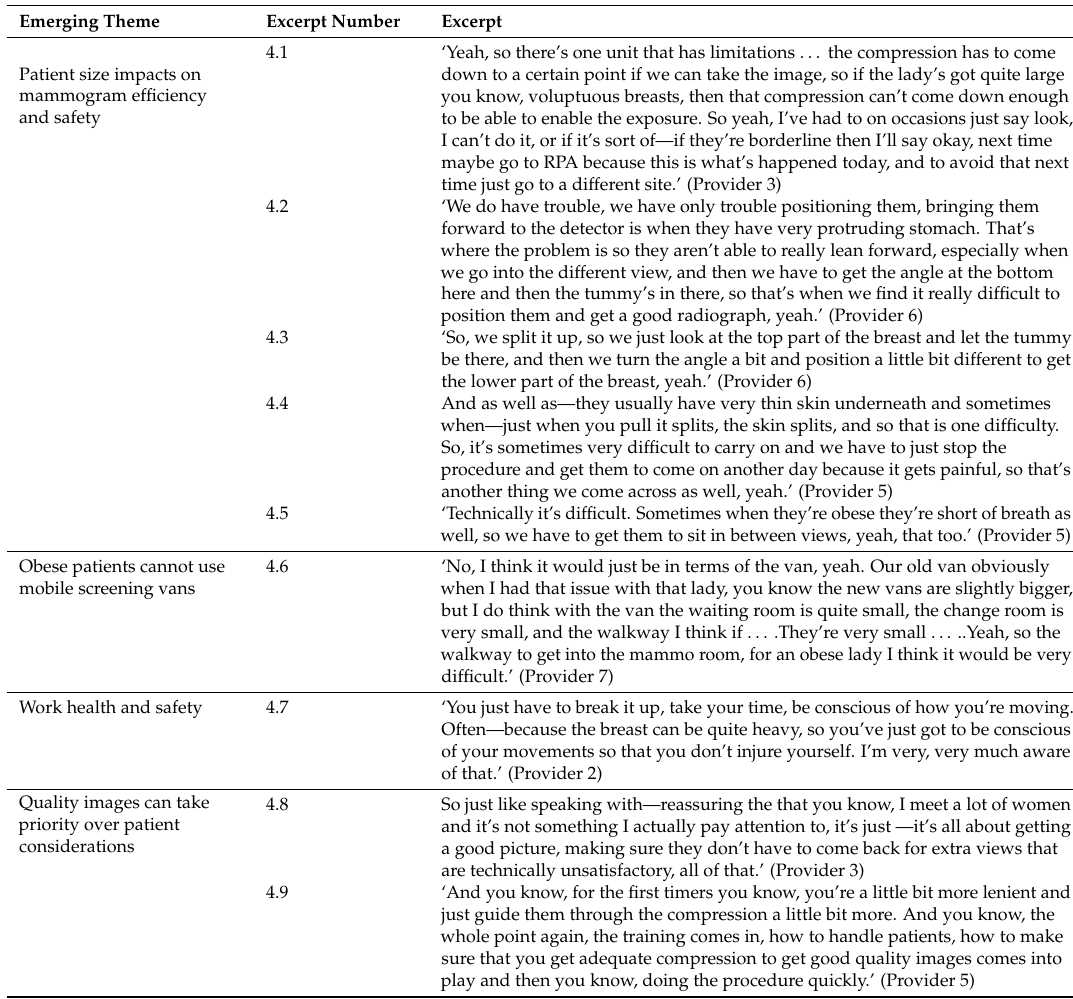
Table 6. Provider reported experiences with obese